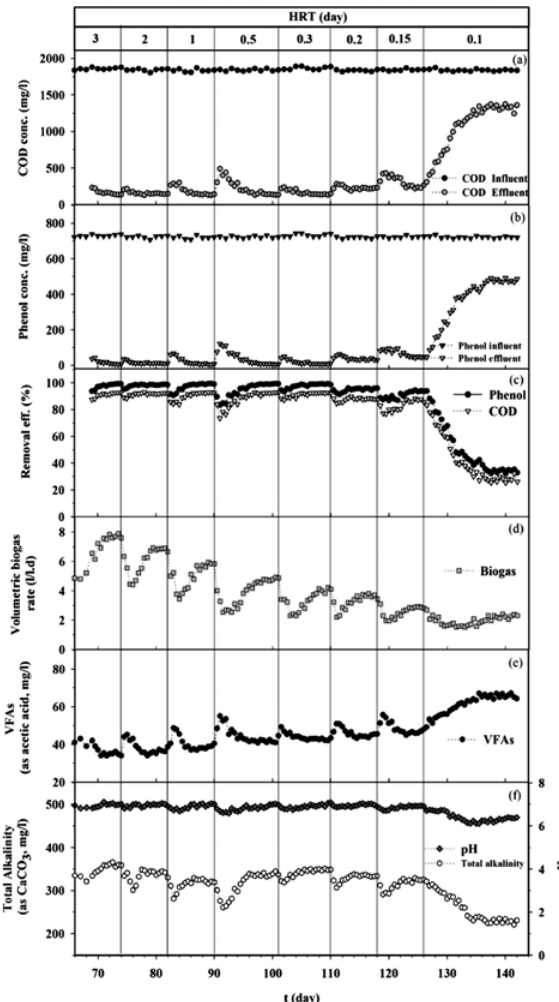
Fig. 3. Effect of decreasing retention time on the AIFBR